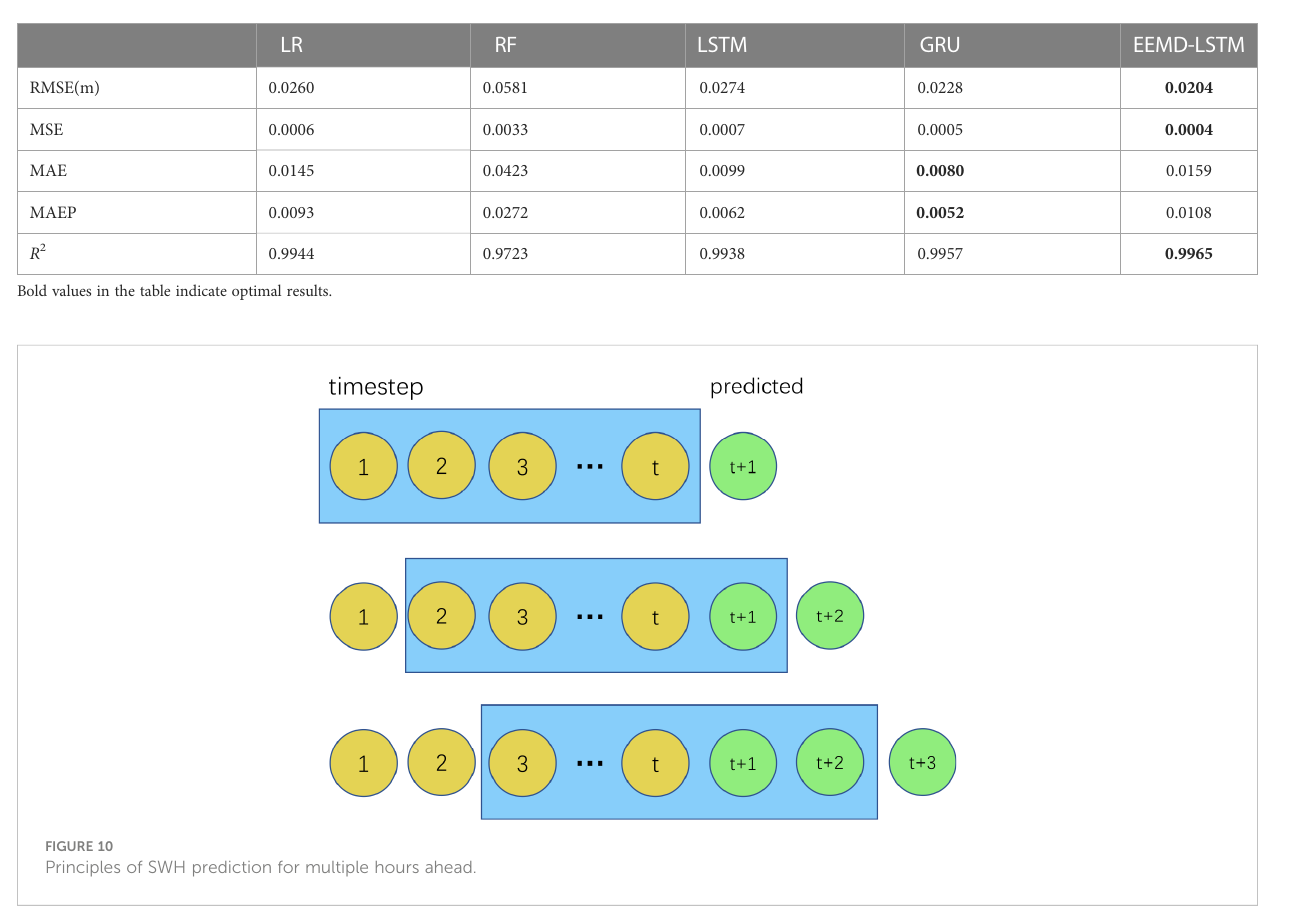
TABLE 4 Prediction effect of different models for future 1-hour SWH.